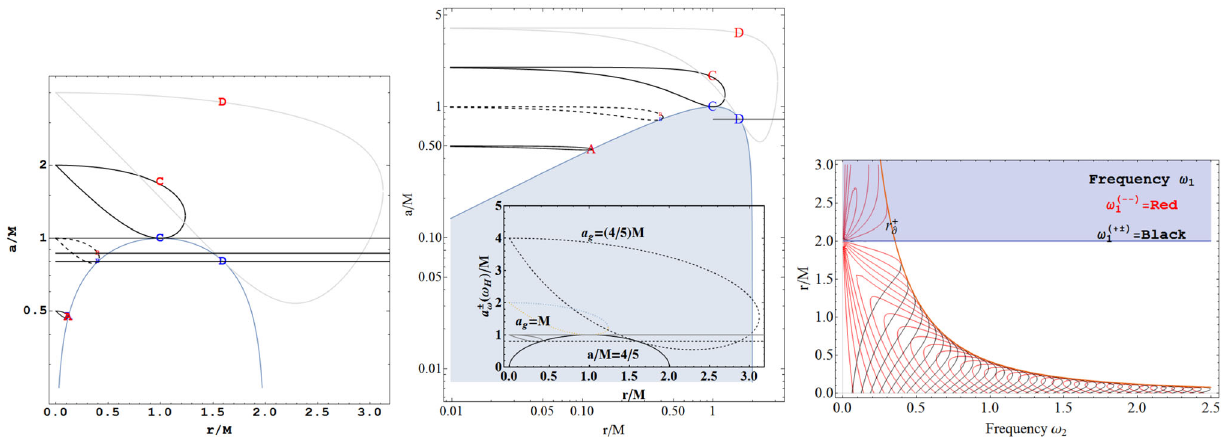
Fig. 15 Left and enter panels: models XX where X = { A , B , C , D } model D ( B ) defines r + ( a g ) ( r − ( a g ) ) for the BH spacetime with spin a = a g .(Centerpanel:)shadedregionisdelimitedbythehorizoncurve. considered in Table 3. The spin a ω as a function of r / M for different origins a 0 with tangent point ( r g , a g ) on the horizon curve. The spins Models XX are shown. Inside panel: bundles parameterized in terms of a g < a o g are represented on X i < X o , where a o g ( X o ) corresponds to the the horizon frequency ω H of Eq. (23) are shown with a g values. Right outer spin of the bundle for r = r g . X = A : origin a 0 = 1 / 2, frequency panel: the shaded region is r > r + (cid:9) = 2 M . Frequencies ω 1 =constant of ω = 2; X = B : a = 1, ω = 2; X = C a = 2, ω = 1 / 2; X = D Eqs. (21), (22) in terms of the frequencies ω 2 and r 0 0 a 0 = 4, ω = 0 . 25. The bundle D is related to C as a g ( D ) = a g ( B ) . The